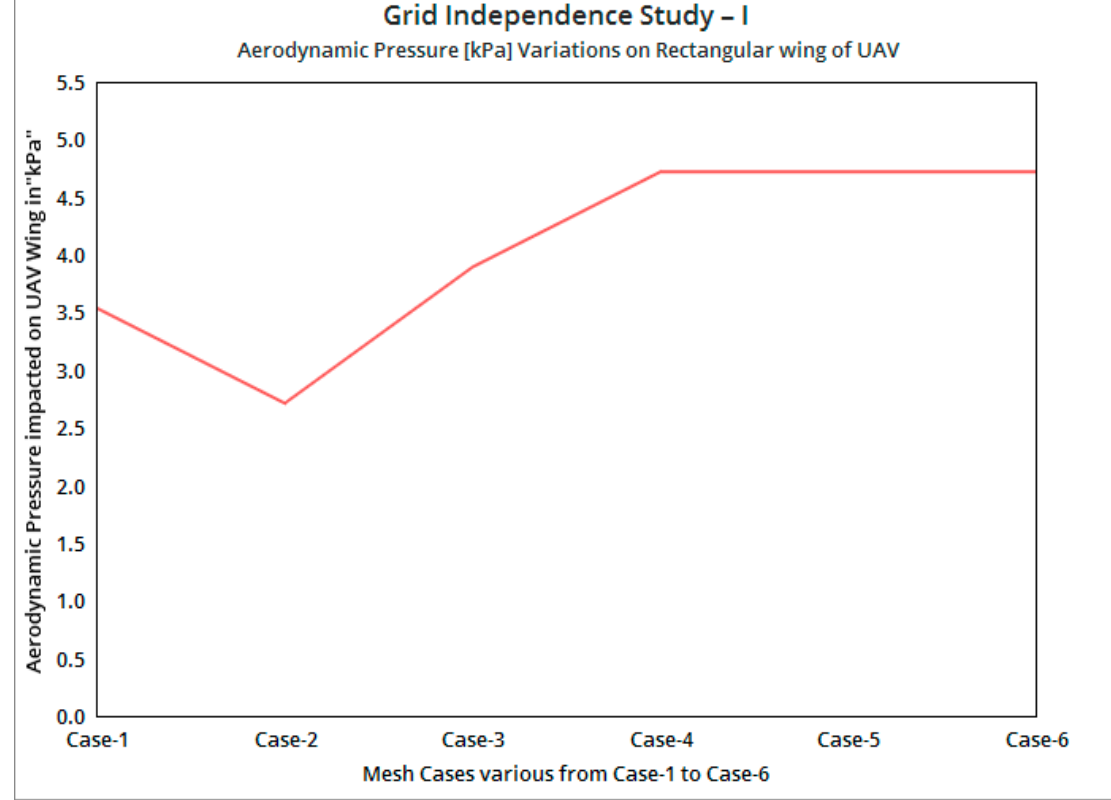
Figure 12. Grid convergence test1 (aerodynamic pressure on UAV-wing in kPa).